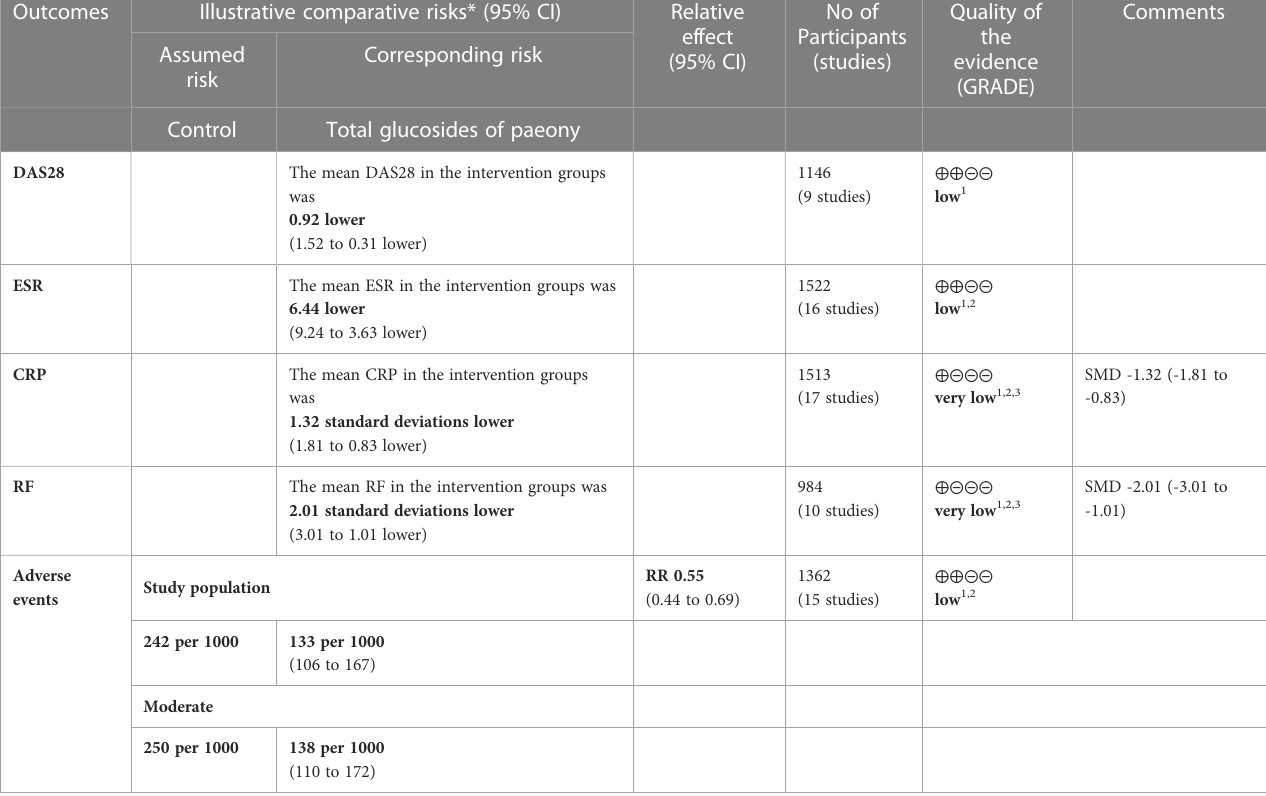
(188), liver protection (189), anticancer (190), antidiabetic (191), cardioprotective (192) and anti-atherosclerotic effect (193). In terms